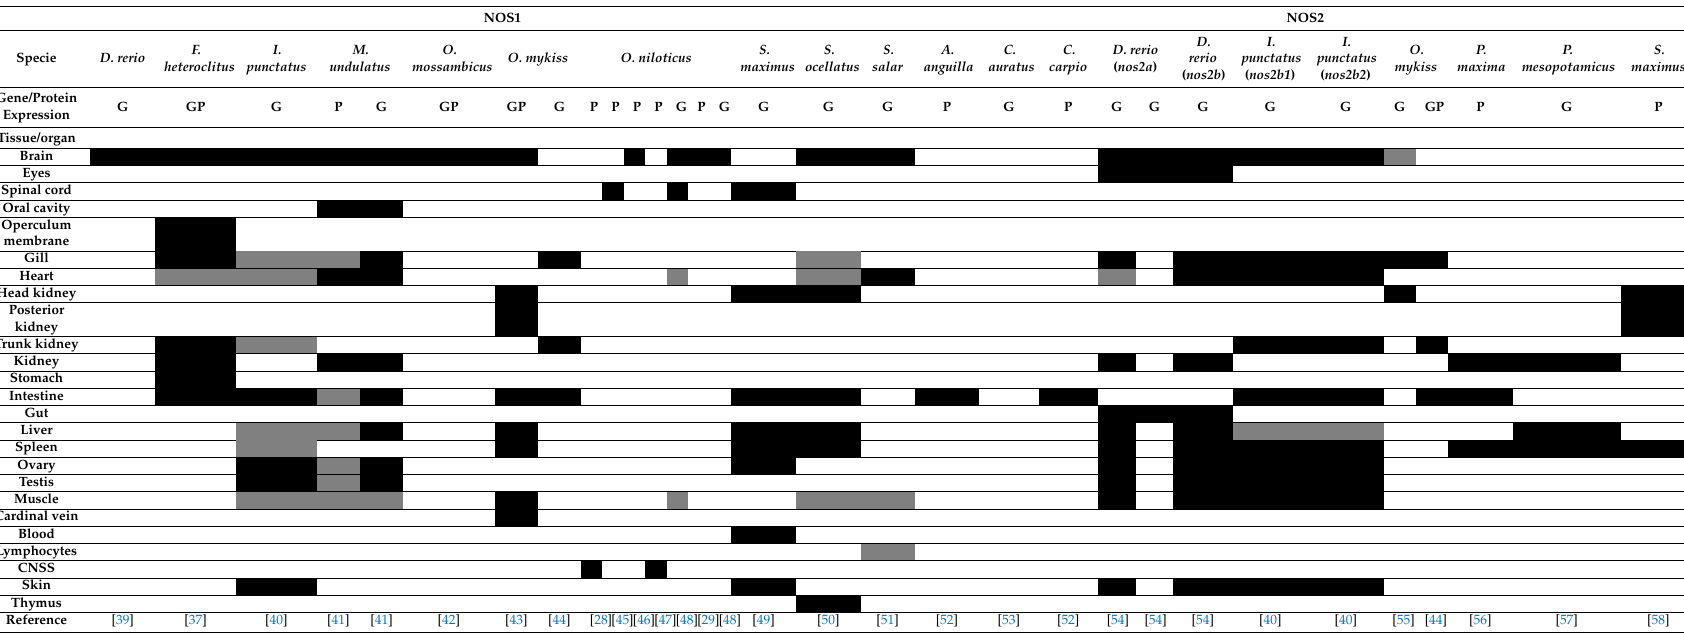
Table 1. Nos enzyme expression detected in different tissues of adult teleosts fish. Black and grey cells indicate respectively the detected and undetected Gene (G)/ Protein (P) expression in the related